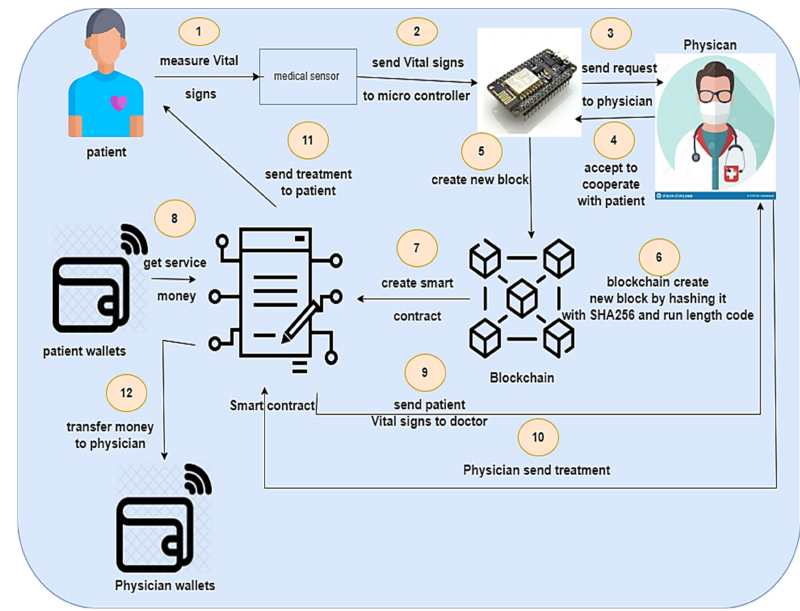
Figure 2. Application scenario of our proposed